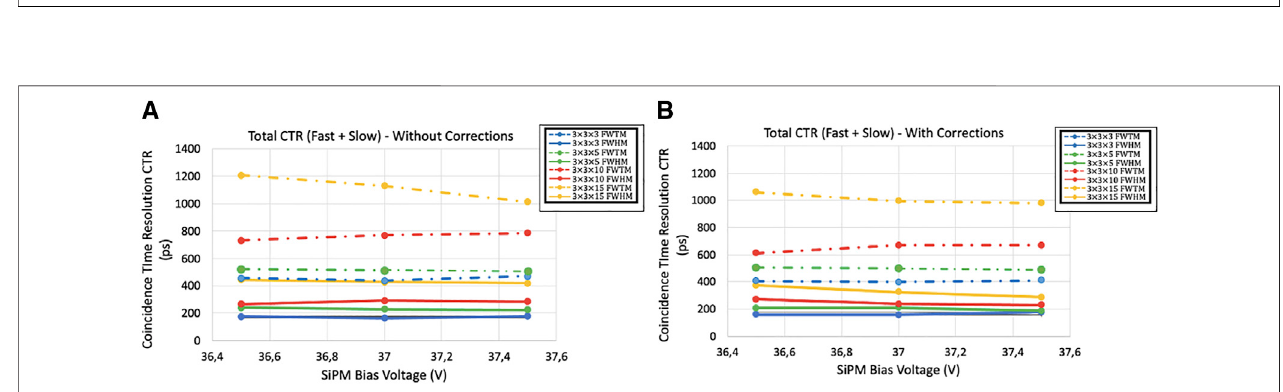
FIGURE7|(A,B) .FWHM(solidlines)andFWTM(dashedlines)CTRvaluesachievedasafunctionoftheSiPMbiasvoltageforeachofthedifferentevaluatedBGO crystal pairs before and after applying the corrections,